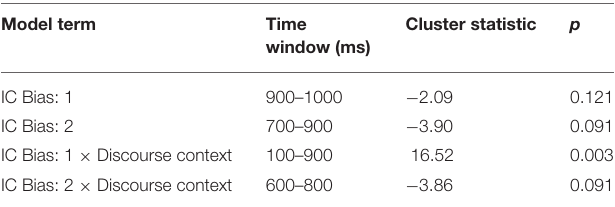
TABLE 2 | Experiment 1: cluster statistics for the model terms, the time window with which the cluster was associated and the proportion of the models that formed the empirical distribution which had a cluster statistic equal to or higher than (or lower than, if the cluster statistic had a negative sign) the cluster statistic found in the data for a given term (the p